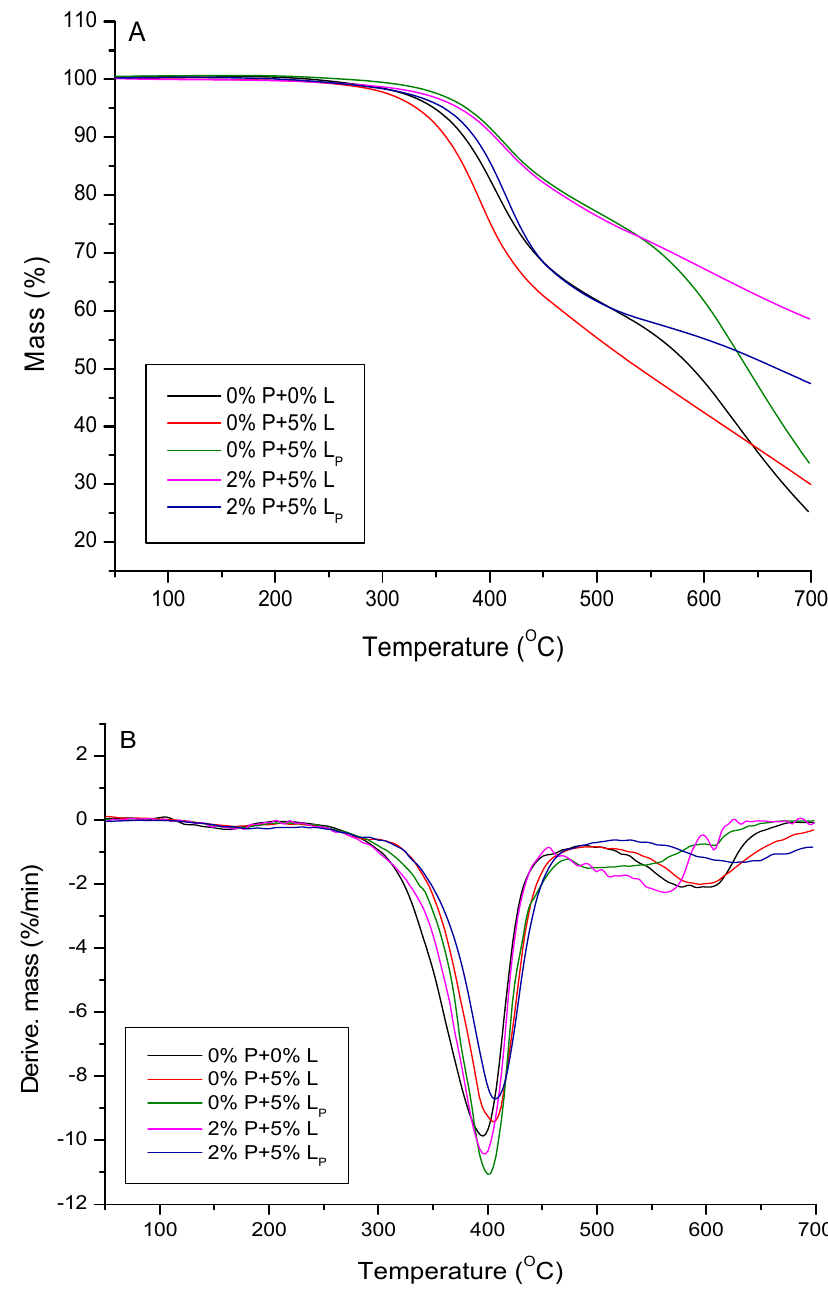
Figure 14. TG ( A ) and DTG ( B ) curves after the flame tests.